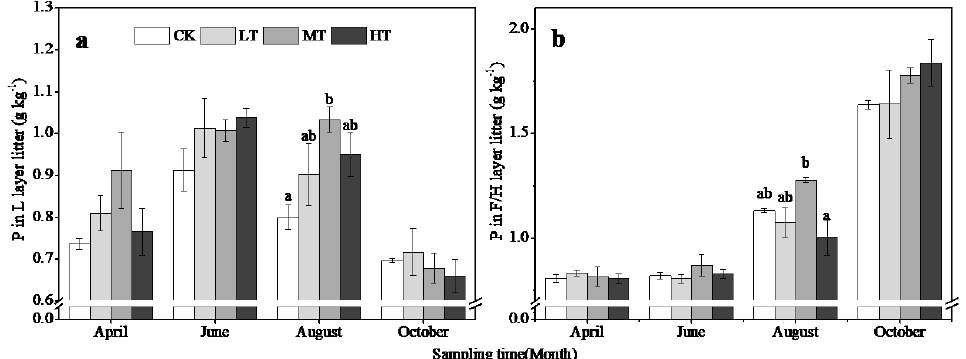
Figure 9. Effects of thinning treatments on P in litter of L layer ( a ) and F/H layer ( b ) at various sampling times in L. principis-rupprechtii plantations. CK, control site; LT, light thinning; MT, moderate thinning; HT, high thinning; L layer, undecomposed litter; F/H layer, mixture of partly decomposed litter and amorphous humus. Error bars indicate standard error ( n = 3). Values within each sampling time followed by different letters differ significantly according to Tukey's test ( p <0.05). When the difference was not statistically significant, no letter notation was noted.